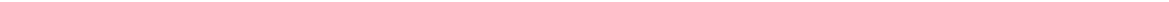
Fig. 1 Macrophage GRIP1 is a GR coactivator of anti-in fl ammatory genes. GRIP1 was depleted in a THP1 cells (using a human-speci fi c small-hairpin (sh) GRIP1 vs. scrambled (shSCR) control) or b mouse BMM Φ (from GRIP1 KO vs. WT control mice), and the induction of indicated genes by